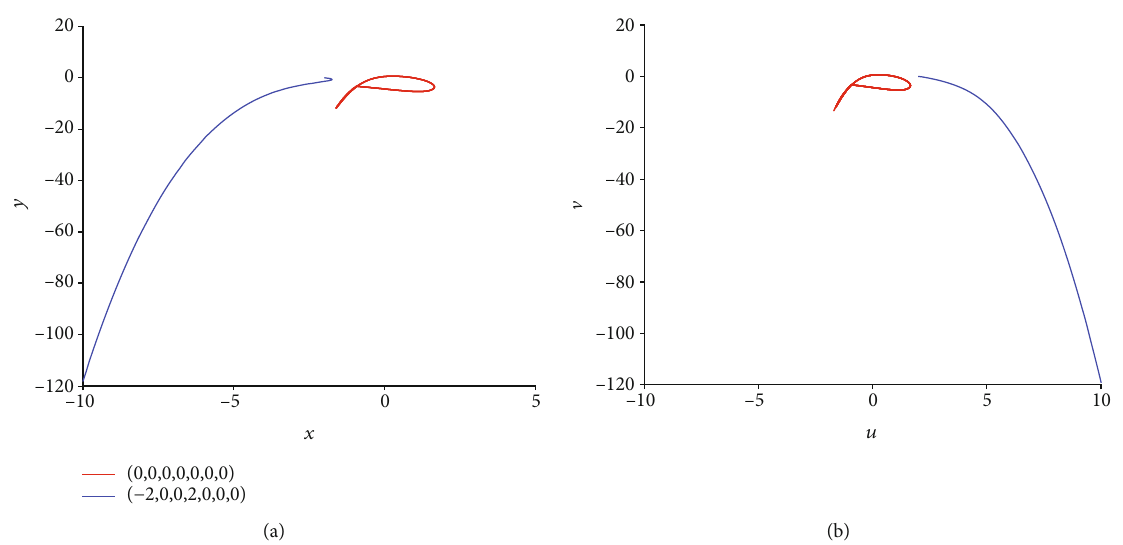
Figure 14: Coexistence of multiple fi ring patterns dependent on initial values in model (2) with k = 0 : 5 and I for initial value ð 0, 0, 0, 0, 0, 0, 0 Þ while the blue one is for ð − 2, 0, 0, 2, 0, 0, 0 Þ